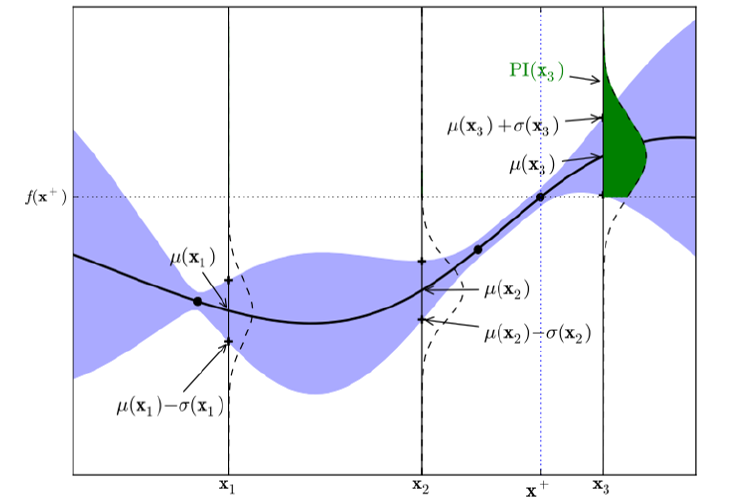
Figure 2. An example of the region of probable improvement [18].